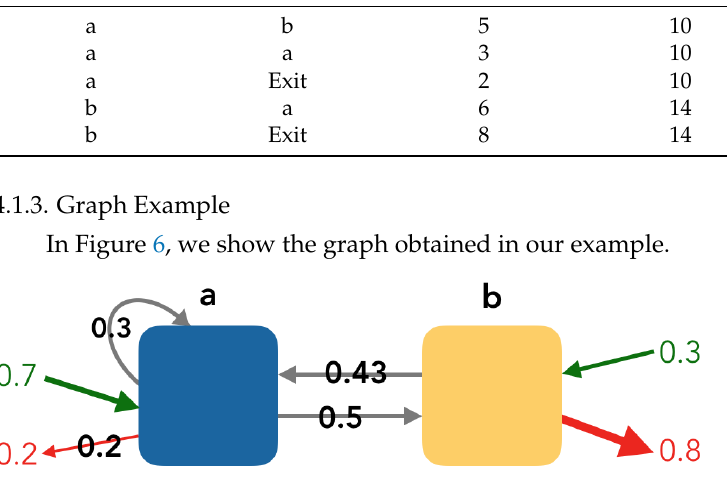
Table 7. Example of weight calculation. The out-degree frequency O i is the sum of frequencies f ij of edges with the same source rule. Thus, O a = 5 + 3 + 2 = 10 and O b = 6 + 8 = 14. Source Rule i